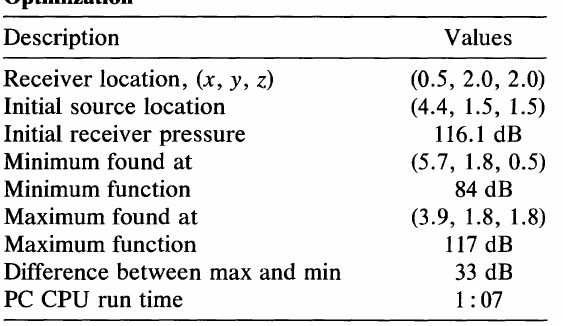
Table 1. Results of a Station Source Location